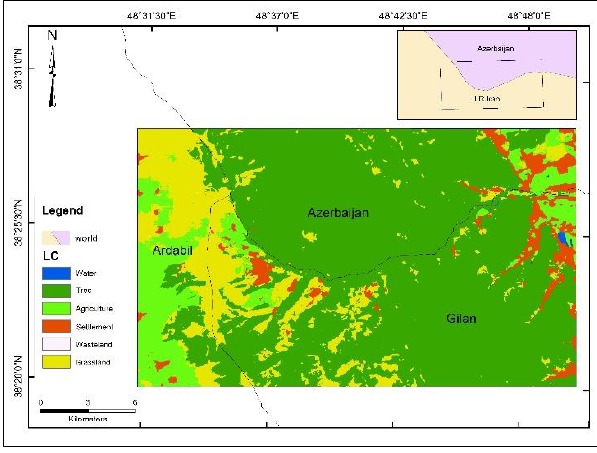
Figure 1. The study